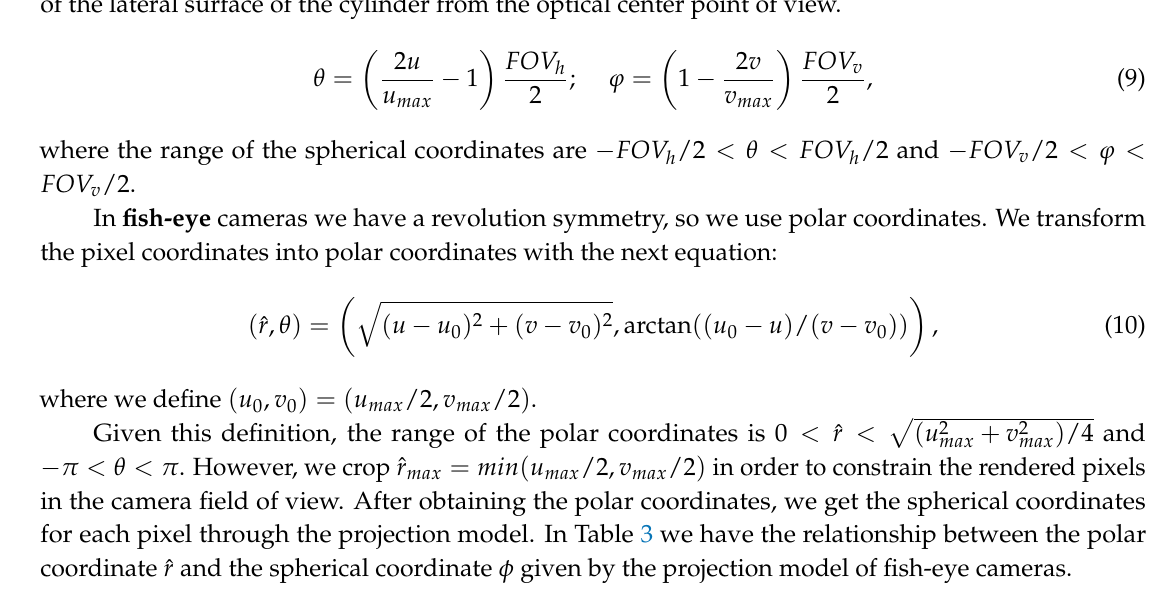
Table 3. Relationship between ˆ r and φ from the fish-eye projection model.